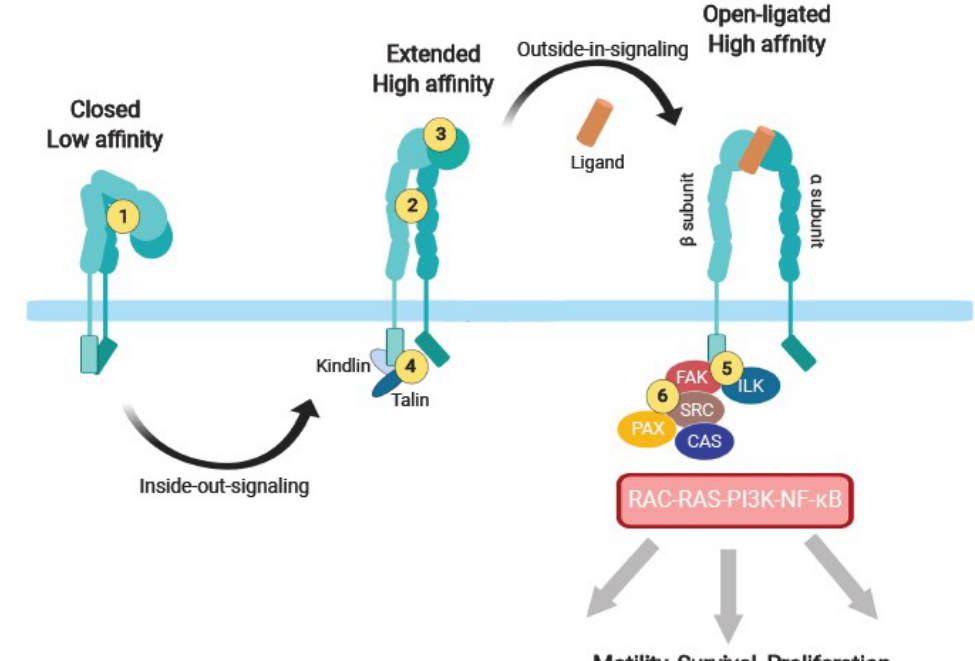
Figure 3. Alternative strategies to inhibit integrins. Current integrin inhibitors are mostly based on preventing ligand binding through direct competition or (allo)steric interference with the extracellular domains. However, some of these ligand-binding inhibitors may activate integrins and do not fully suppress integrin signaling. Alternative approaches to interfere with integrin function may be considered since integrin activation and signaling are complex events involving multiple and different steps. Strategies to consider include: 1, the retention of bent integrins in their low-affinity state; 2, the prevention of full integrin extension and affinity maturation; and 3, irreversible preclusion of ligand binding by covalent modification of the binding pocket. The intracellular domains and the adhesome also provide additional opportunities, including: 4, interfering with kindlin/talin-mediated activation; 5, the prevention of recruitments of signaling proteins of the adhesome (e.g., FAK) to the β cytodomain; 6, the prevention of adhesome maturation or induction of adhesome dissolution by interfering with protein–protein interactions .